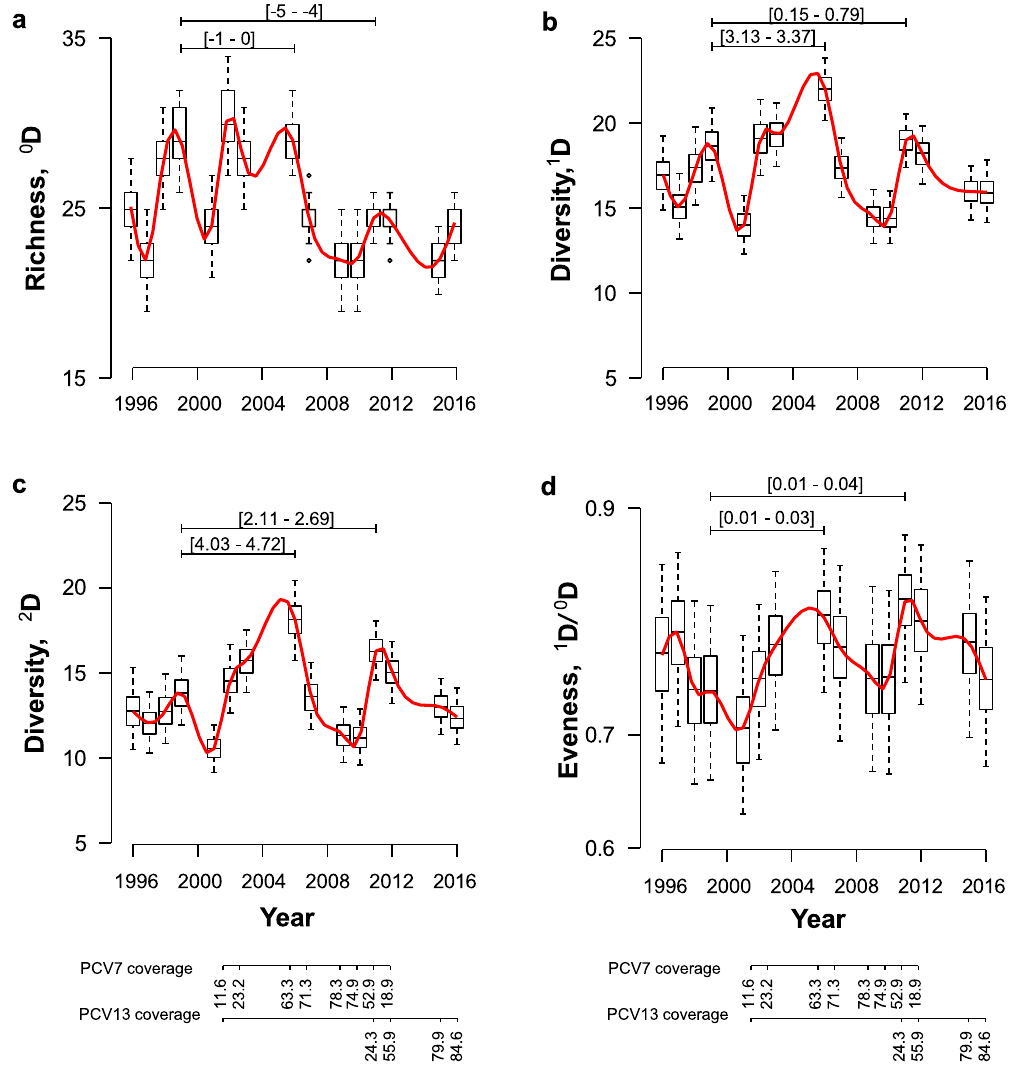
Figure 1. Estimates of pneumococcal serotype diversity per sampling year. ( a ) Richness, 0 D ; ( b ) Diversity, 1 D (exponential of Shannon’s diversity); ( c ) Diversity, 2 D (inverse of Simpson’s index); ( d ) Evenness, 1 D/ 0 D . For each year a boxplot summarizes the data corresponding to estimates of diversity derived from 1,000 bootstrap re-samplings of 275 children. A smooth line, in red, was imposed to each plot. The differences between the diversity medians are shown as 95% bootstrap confidence intervals. Pneumococcal vaccine uptake is shown at the bottom of the